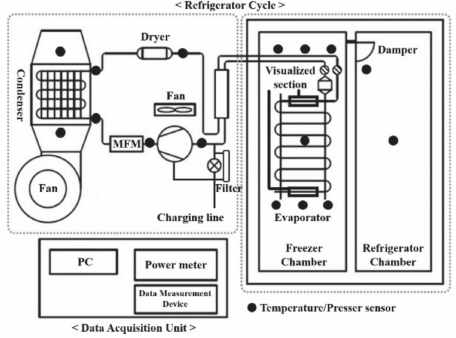
Figure 1. Schematic diagram of experimental system.